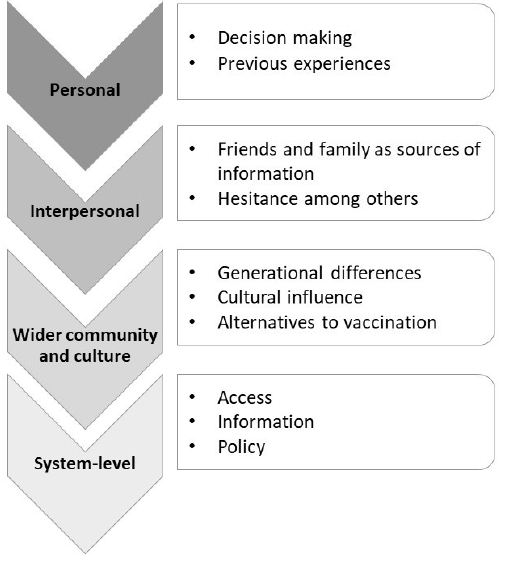
Figure 1. Four main groups of themes.